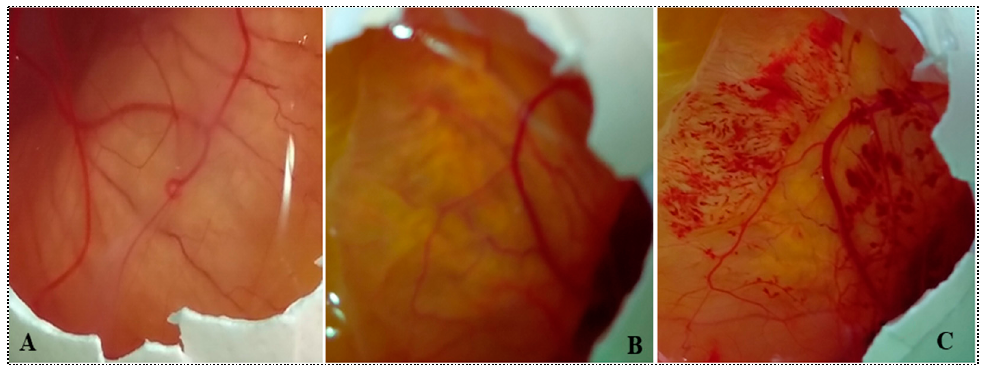
Figure 10. HET-CAM images of ( A ) normal saline, ( B ) moxifloxacin-loaded bilosome in situ gel (MX-BSop-Ig4), and ( C ) positive-control-treated cornea.